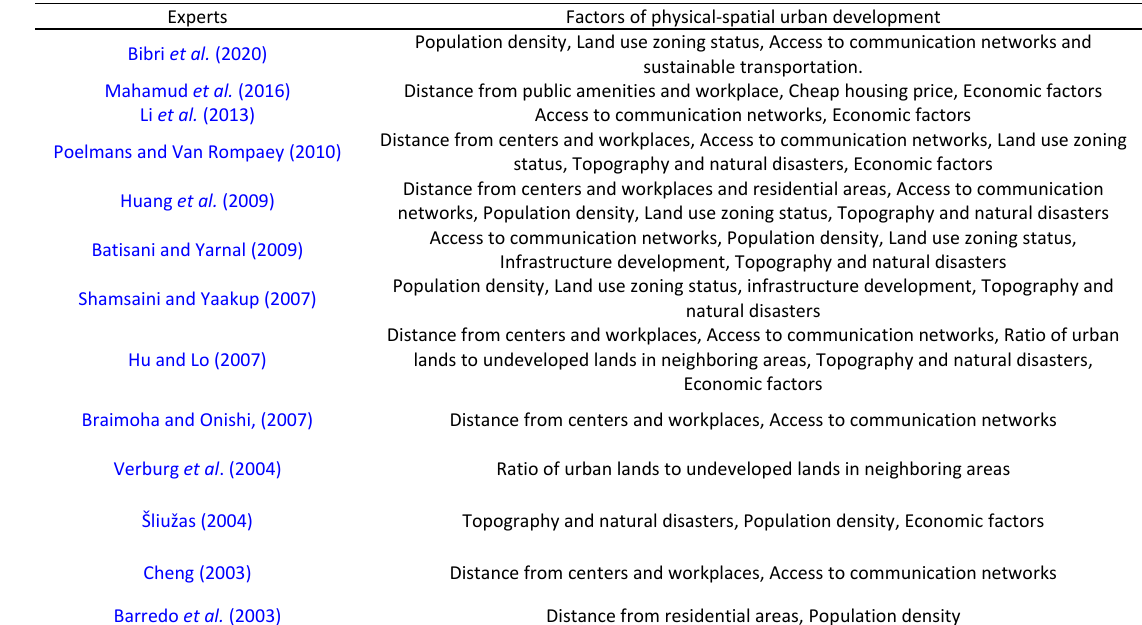
Table 3: Factors affecting the physical‐spatial urban development